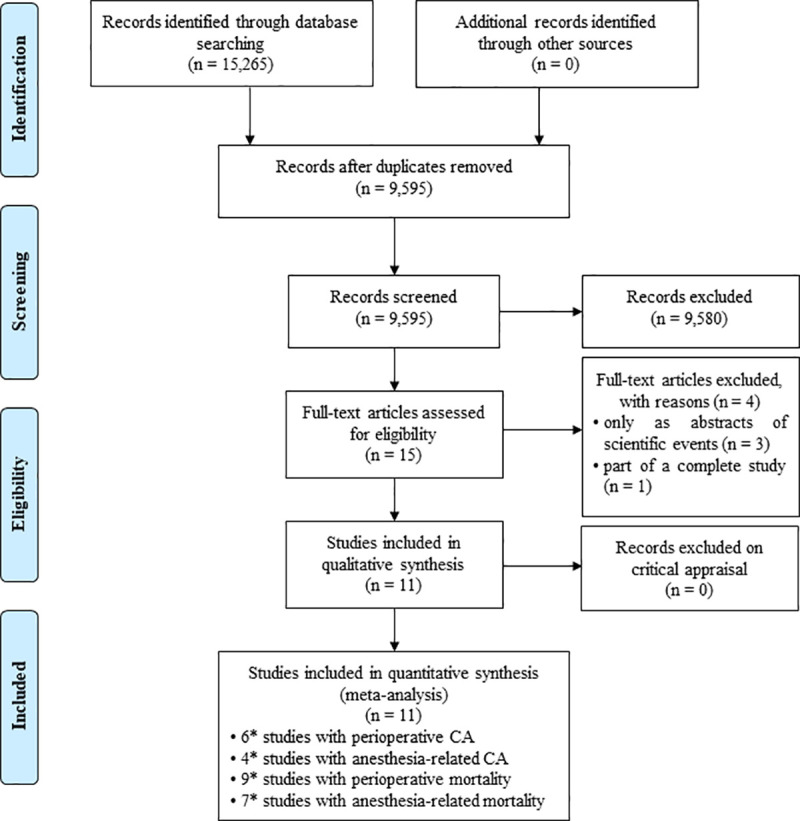
PRISMA flow diagram showing the study selection process.Abbreviations. CA: cardiac arrest; *some studies have been included in more than one category.